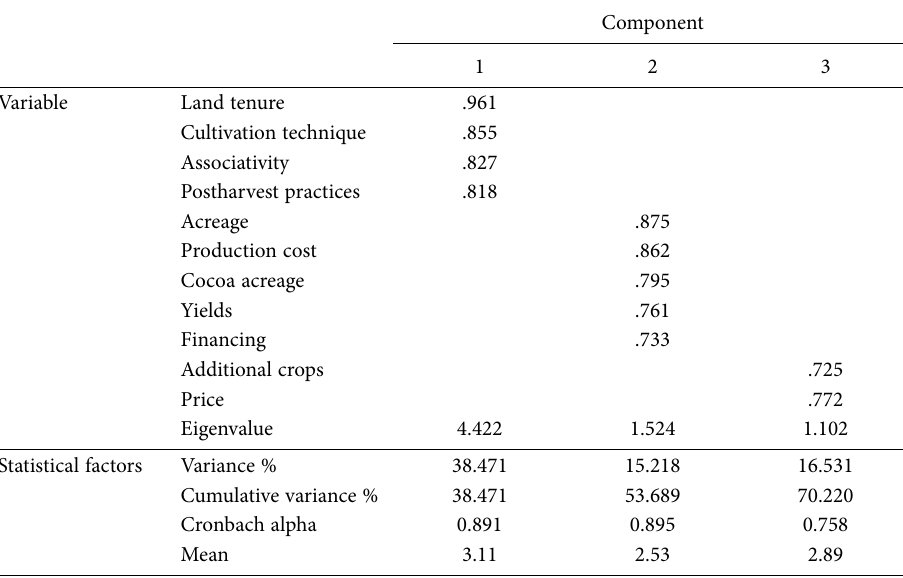
Table 6. Matrix of extracted components from PCA analysis of Arriba cocoa